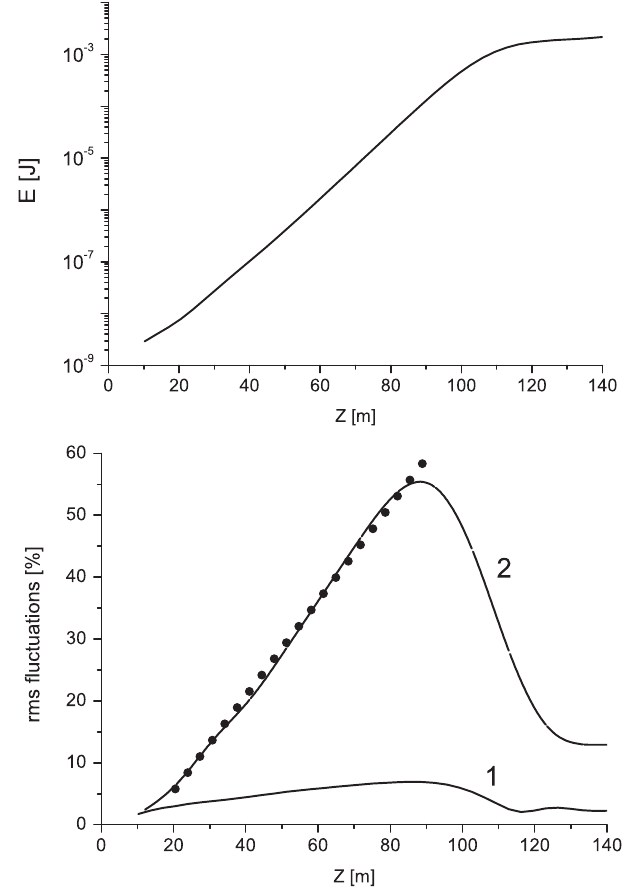
FIG. 1. Results of numerical simulations with FAST . Radiation pulse energy (upper plot) and relative rms fluctuations (lower plot) versus undulator length for SASE1 undulator, operating at 0.1 nm [4]. Curve 1: intrinsic SASE fluctuations (stable electron beam); curve 2: with 10% rms fluctuations of bunch compression factor. Dots are calculated according to formula (1) with L 13 m